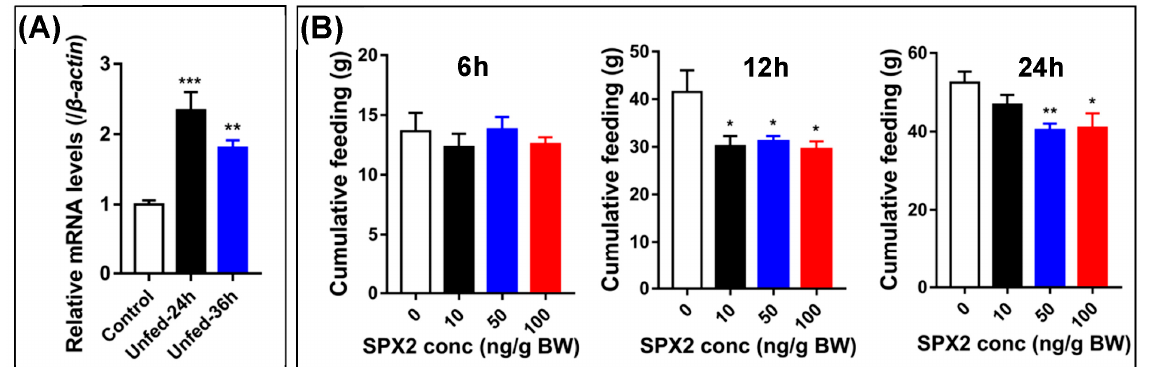
Figure 5. Effects of cSPX2 on chicken food intake. ( A ) Fasting could induce cSPX2 mRNA expression in chick hypothalamus ( n = 8). ( B ) Food consumption of chicks after intravenous injection of cSPX2 for 6 h, 12 h, and 24 h. Each data point represents the mean ± SEM ( n ≥ 8). * p < 0.05, ** p < 0.01, *** p < 0.001 vs. respective control.